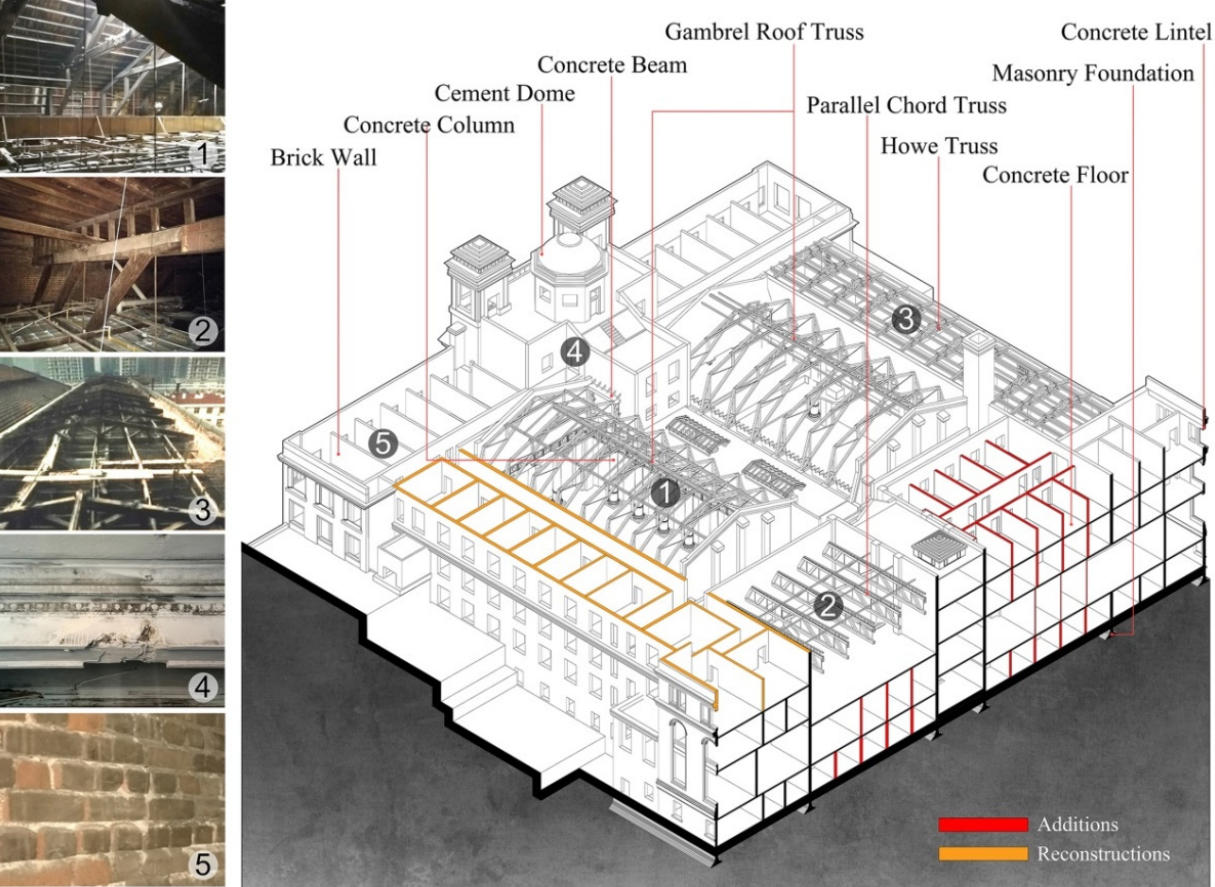
Figure 10. Structure of Qingdao Exchange Building.